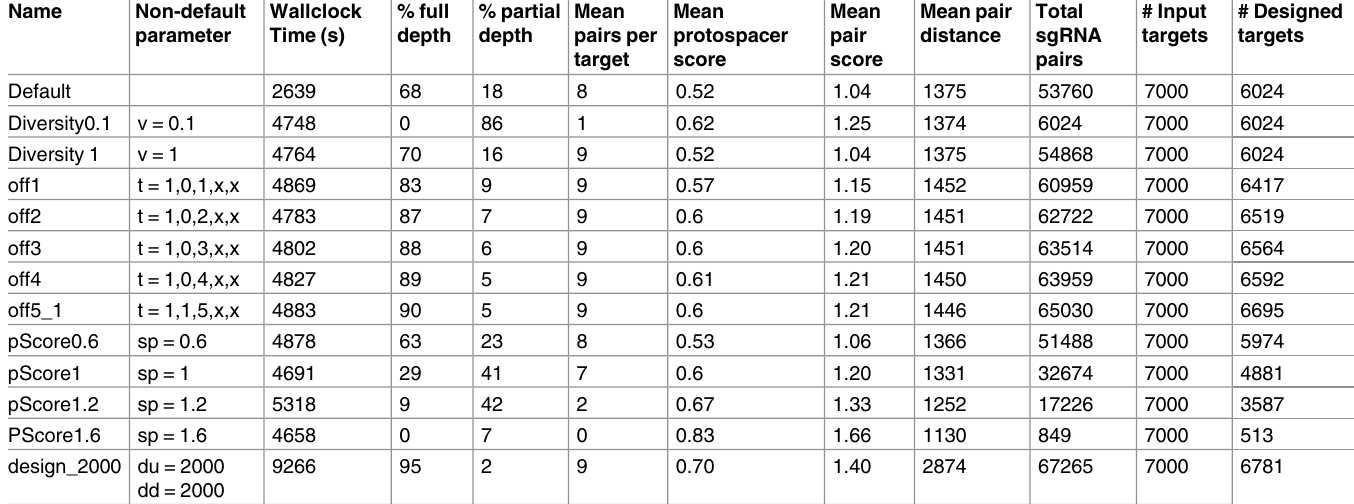
Table 3. Benchmarking results. Analyseswere performed on a set of 7000 regions composed of different humantarget types (see Methods for details). % full depth refers to the percent of targets receiving n = 10 sgRNA pair designs.% partial depth refers to targets receiving0 < n < 10designs.Designedtargets refers to the total number of target features receivingfull or partial depth